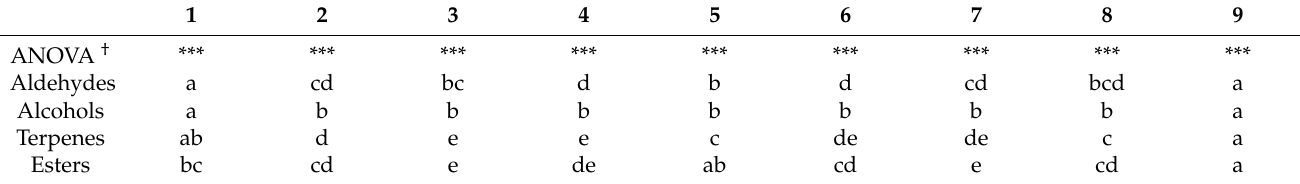
Table 4. Statistical differences found between the different chemical families. † *** significant at p < 0.001. Values followed by the same letter, within the same chemical family were not significantly different ( p < 0.05), according to Tukey’s least significant difference test. Rootstock: “Carrizo citrange” (1), “Swingle citrumelo CPB 4475” (2), “Macrophylla” (3), “Volkameriana” (4), “Forner-Alcaide 5”